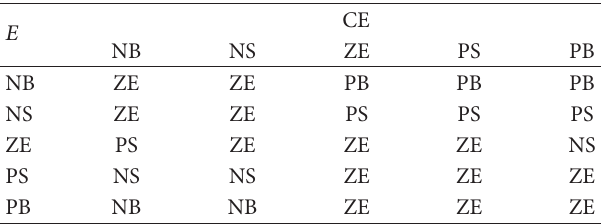
Table 3: The twenty-five fuzzy rules of the second fuzzy subset (S2).